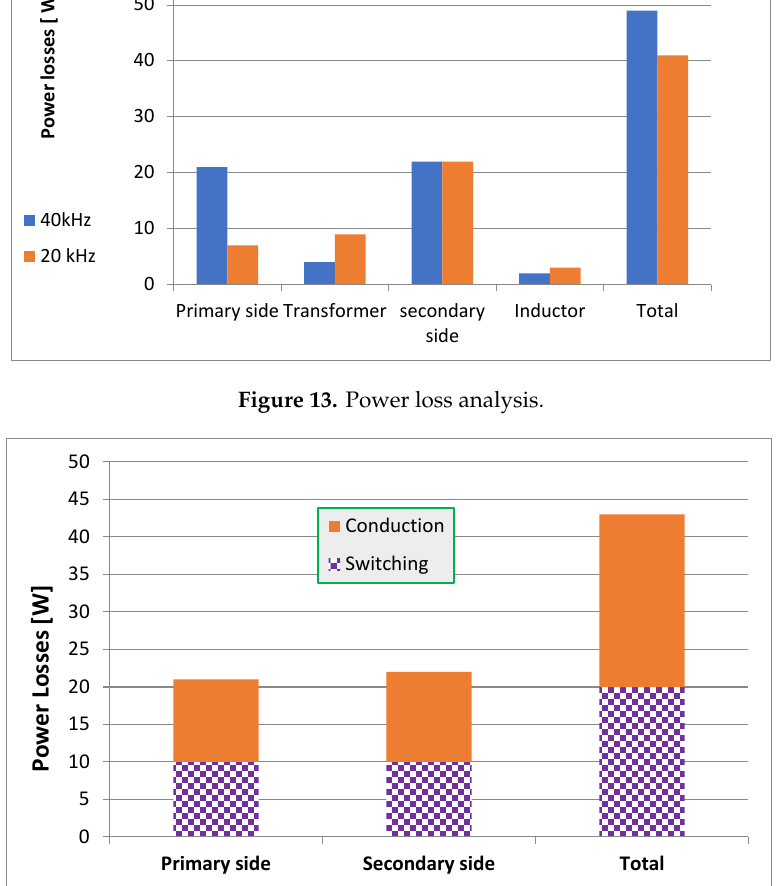
Figure 14. Comparison of conduction losses with switching losses.